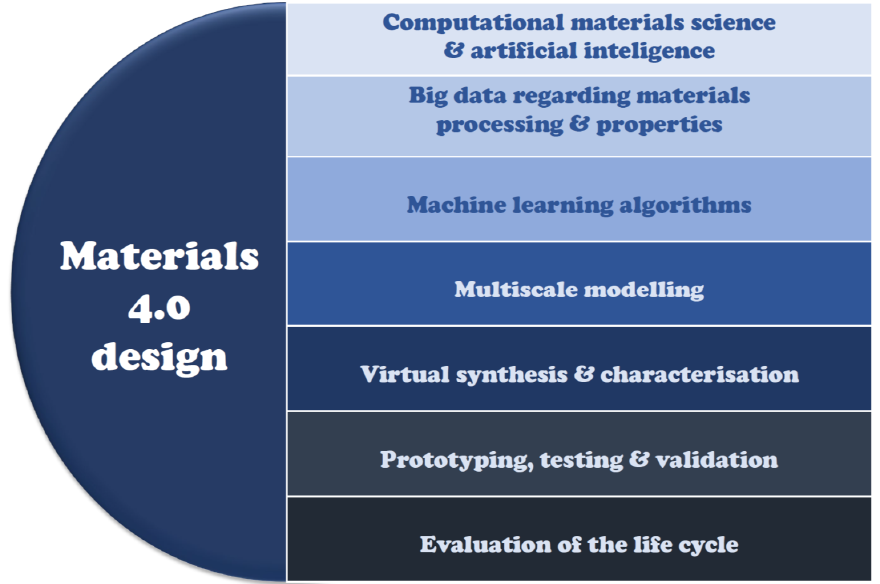
Figure 8. Materials 4.0 methodology of material design using cyber-physical systems and advanced information technologies.